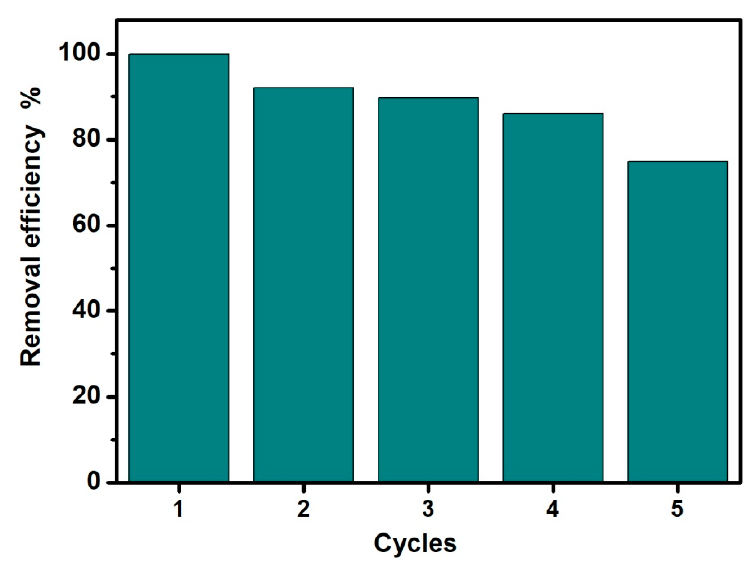
Figure 10. Adsorption–desorption cycle of SG-PEI/rGH for Hg 2+.